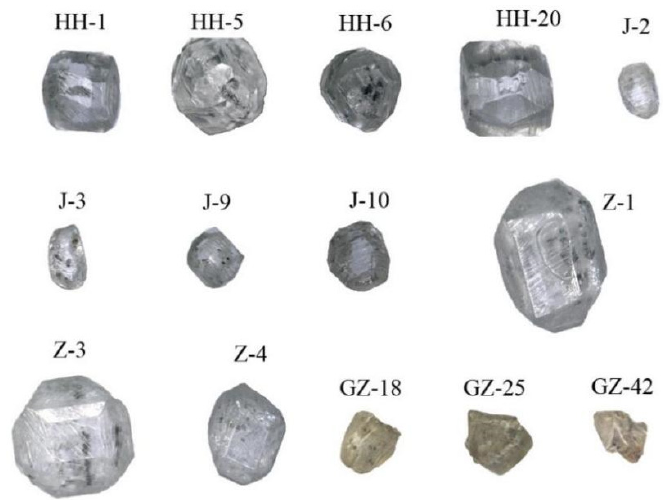
Figure 2. Diamond samples. Table 1. Characteristic of Chinese HPHT synthetic diamonds in recent